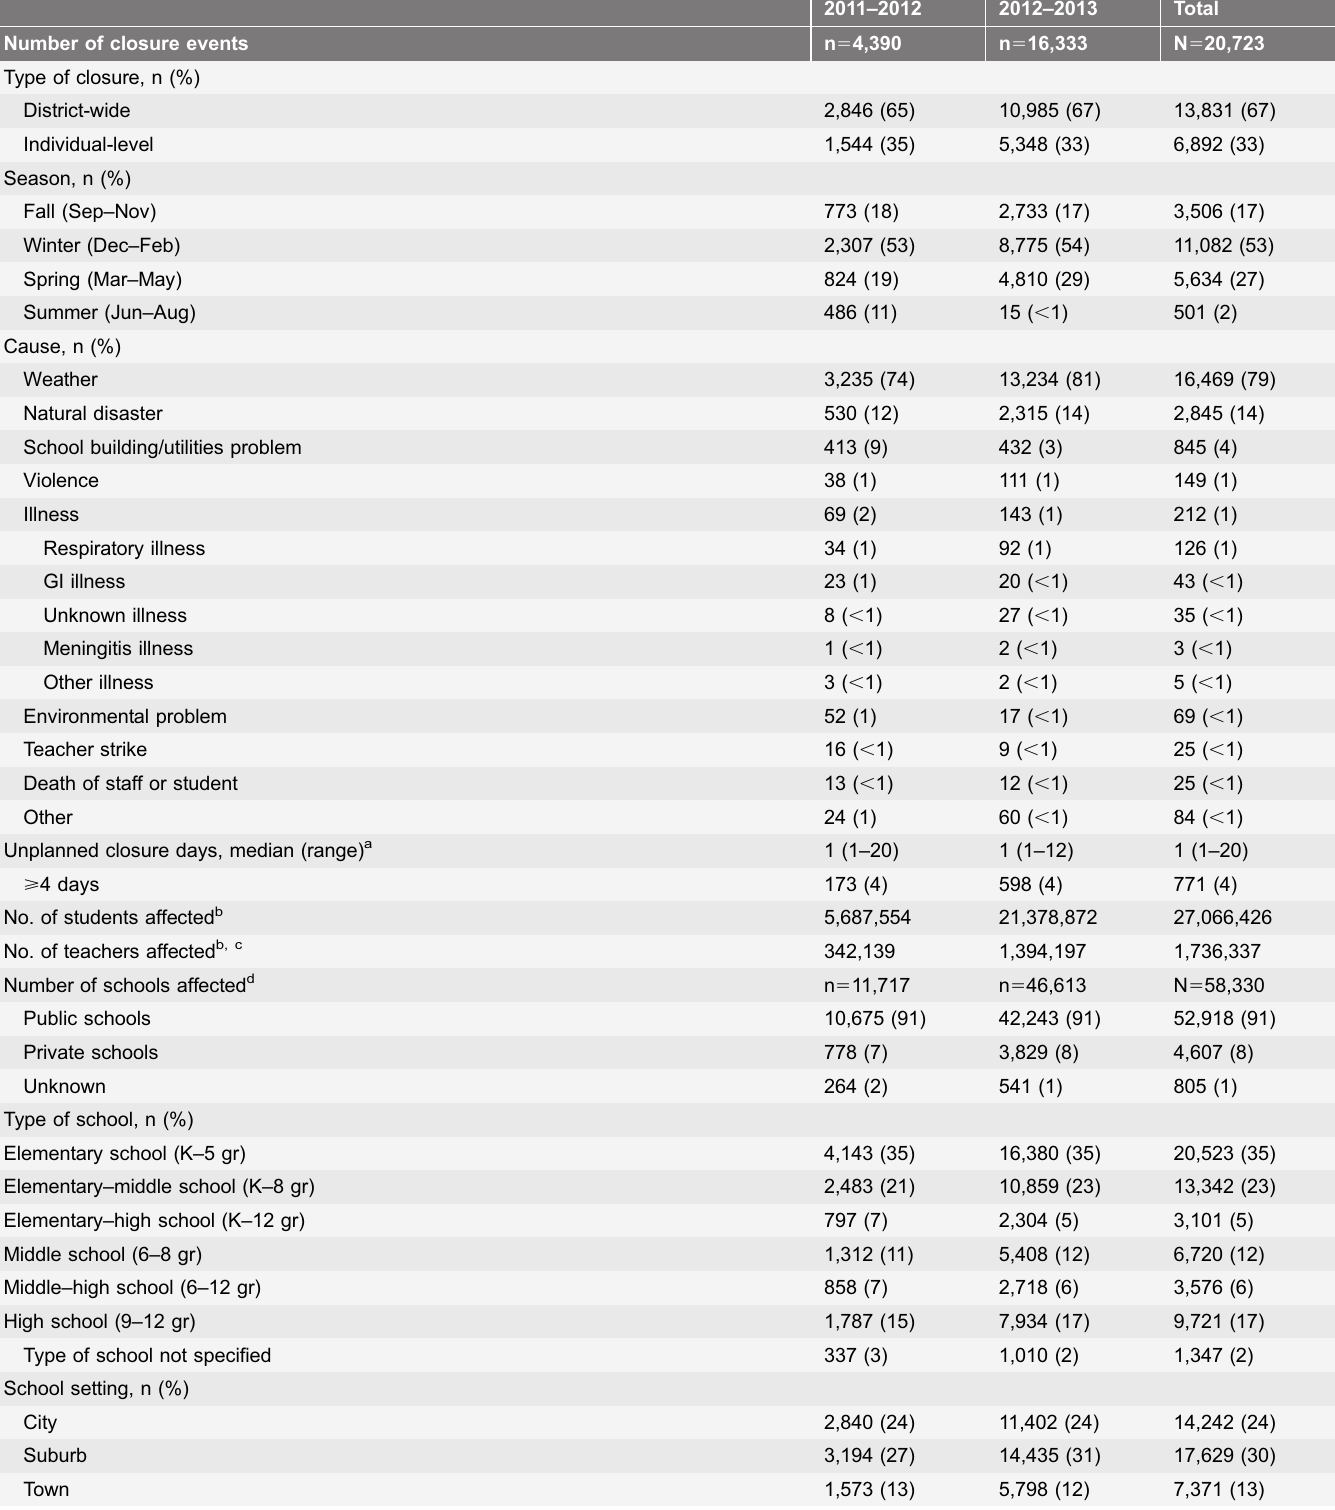
Table 1. Characteristics of school closures by academic year — United States,